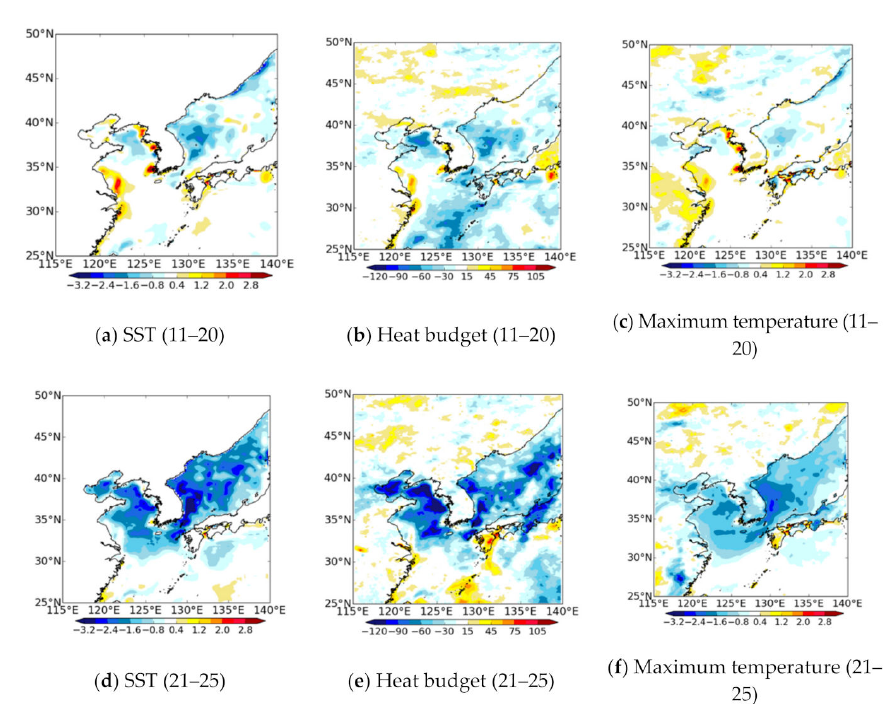
Figure 12. Di ff erences between the CP and CTL experiment (CP minus CTL) for ( a , d ) SST (K), ( b , e ) heat budget (Wm-2) and ( c , f ) daily maximum temperature (K). ( a – c ) are averaged during 11–20 and ( d – f ) are averaged during 21–25 August 2016. All experiments are forecasted at 7 days before the targeted time. The heat budget is calculated by the sum of net downward longwave radiation flux, net downward shortwave radiation flux and latent and sensible heat fluxes.